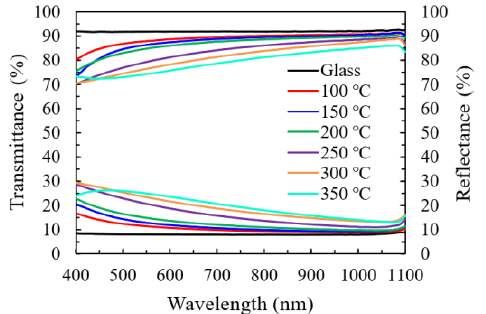
Figure 8 . The transmittance and reflectance spectra of the In 2 O 3 /glass specimens prepared with different substrate temperatures.